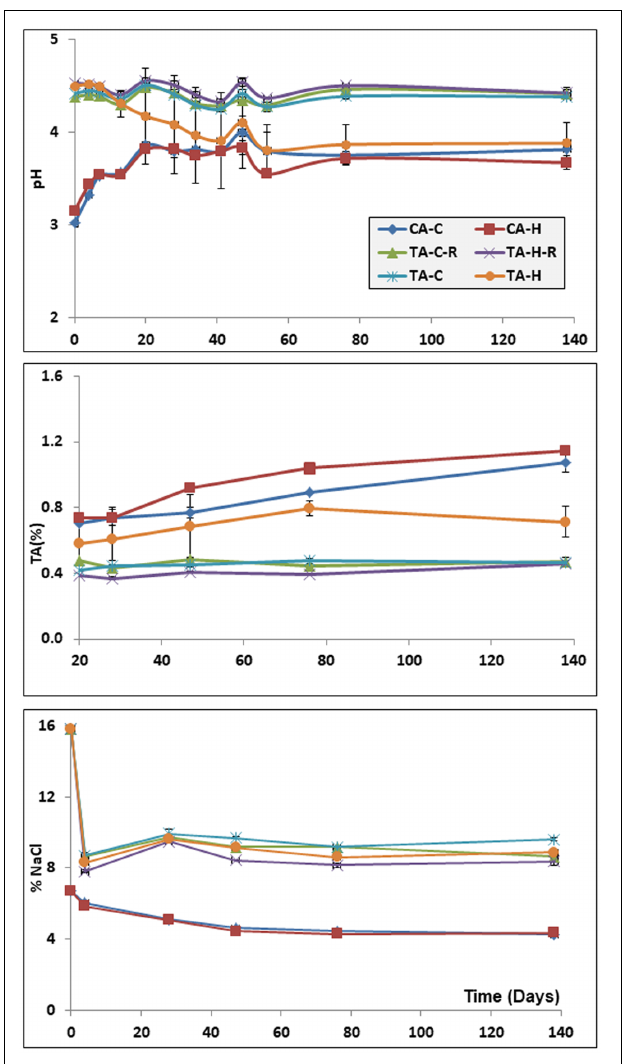
FIGURE 1 | Evolution of the pH (upper) , titratable acidity (middle) and salt content (lower) during fermentation in the diverse treatments. Error bars denote standard deviation calculated from duplicate fermentation vessels. CA-C, cured control; CA-H, heat-shocked cured olives; FG-C, refrigerated fresh green control; FG-H, heat-shocked refrigerated fresh green olives; TA-C, control of traditional olives; and TA-H, heat-shocked traditional olives. All treatments were applied to the Aloreña de Malaga cultivar.